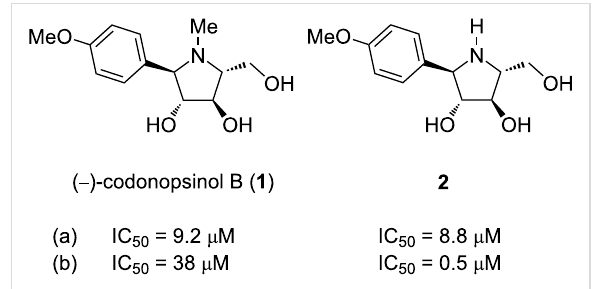
Figure 1: ( − )-Codonopsinol B ( 1 ) and its N -nor-methyl analogue 2 ; known inhibition activities against α -glucosidases from: (a) Bacillus stearothermophilus lyoph. , (b) yeast